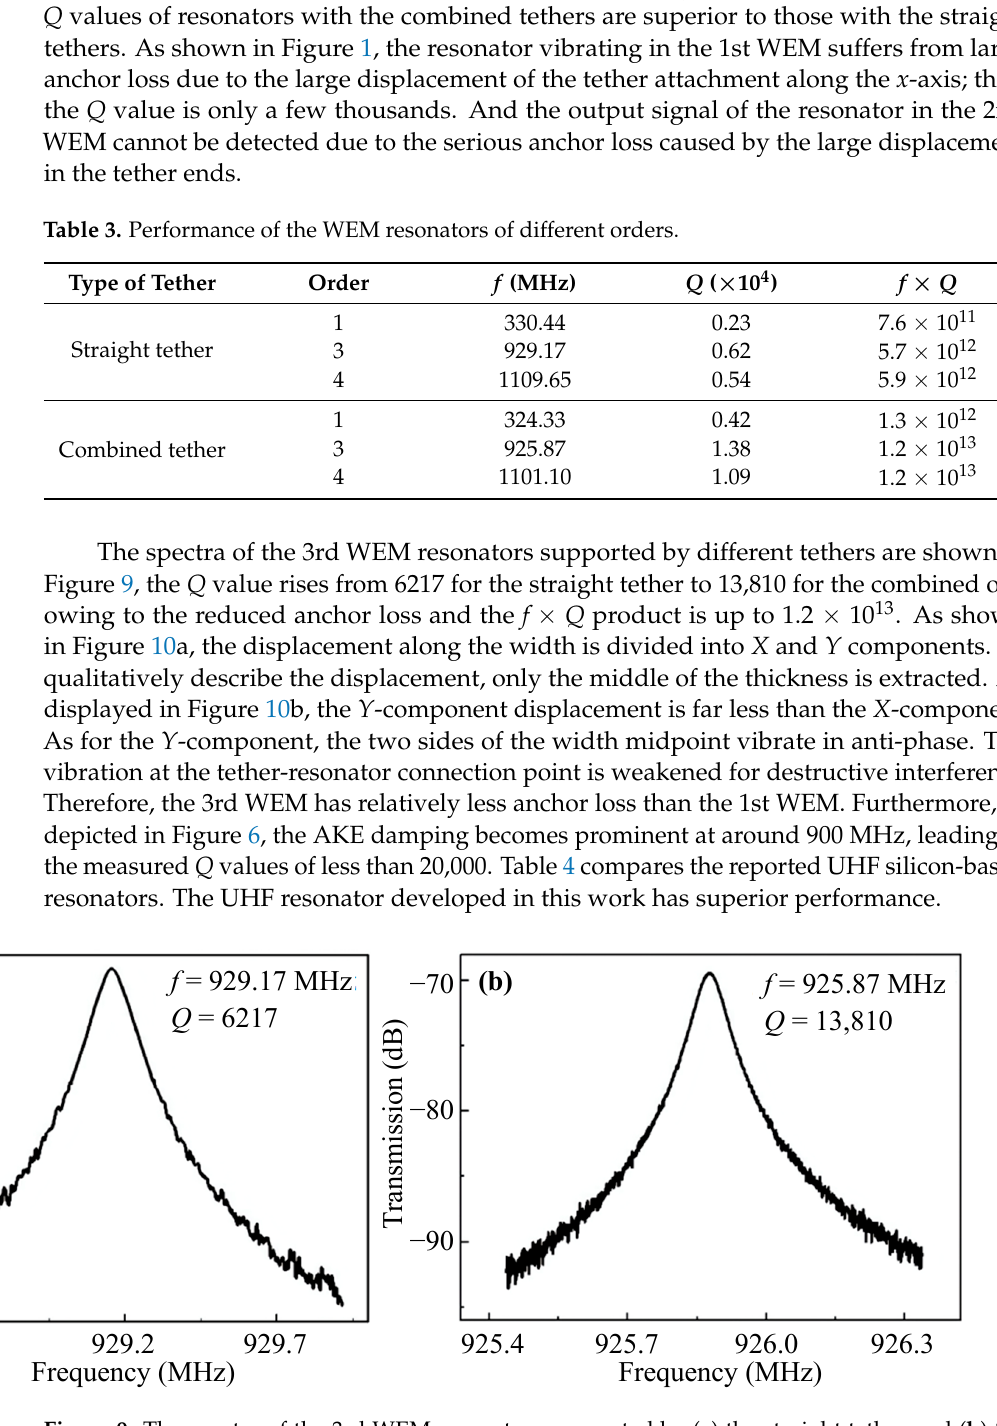
Figure 9. The spectra of the 3rd WEM resonators supported by ( a ) the straight tether and ( b ) the combined tether in vacuum.